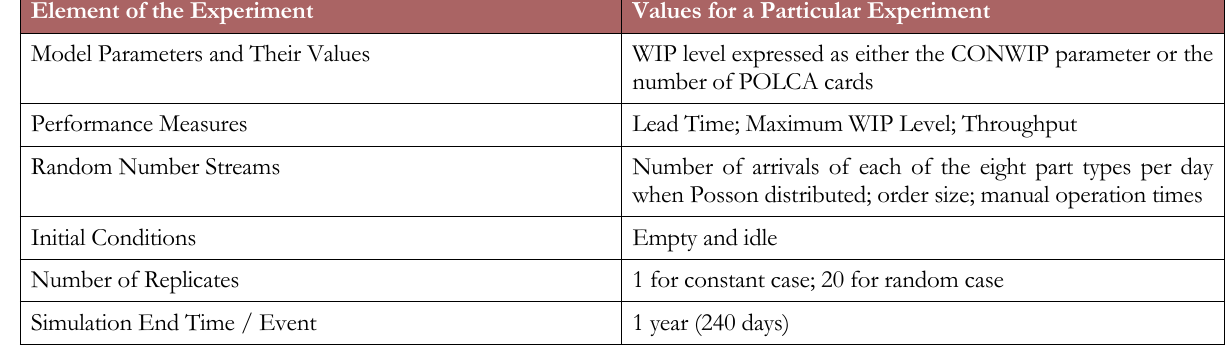
Table 4. Simulation Experimental